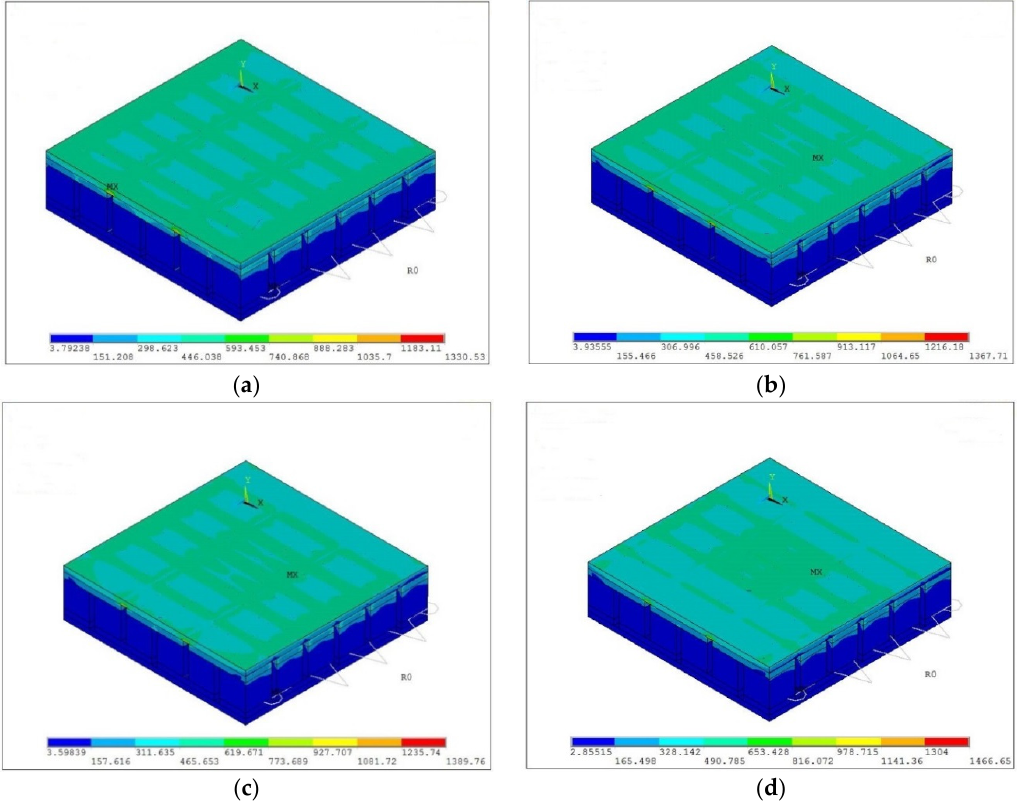
Figure 4. The effect of heating uniformity (U f )on the distribution of thermal stress when P is 22.05 W (Unit: MPa): ( a ) U f = 100%; ( b ) U f = 70%; ( c ) U f = 50%; ( d ) U f = 30%.